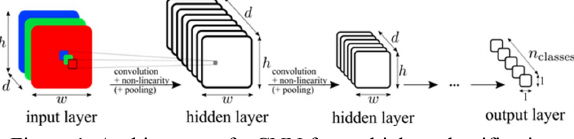
Figure 1. Architecture of a CNN for multiclass